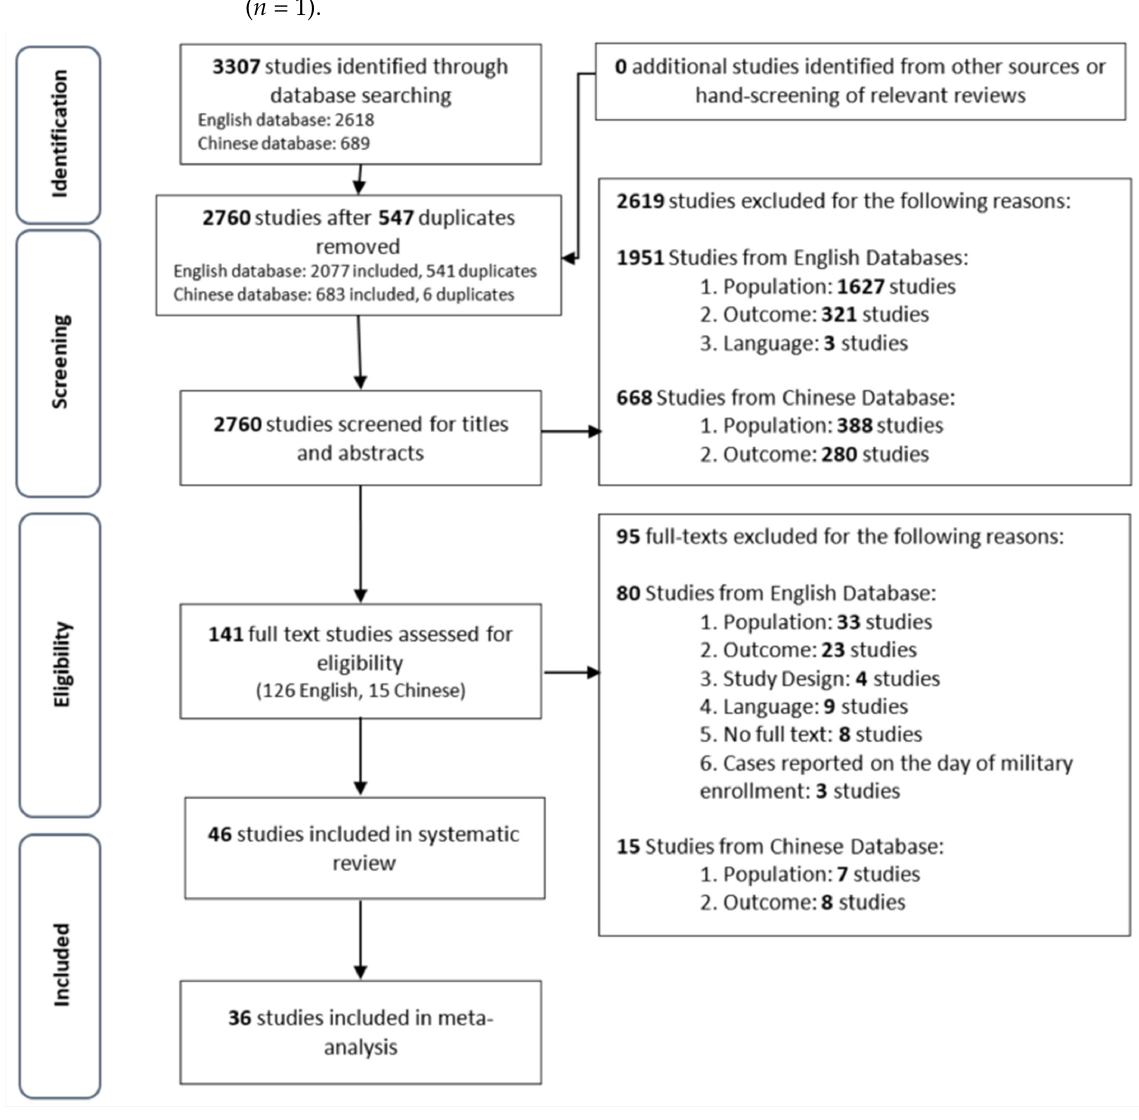
Figure 1. PRISMA flowchart of study selection.